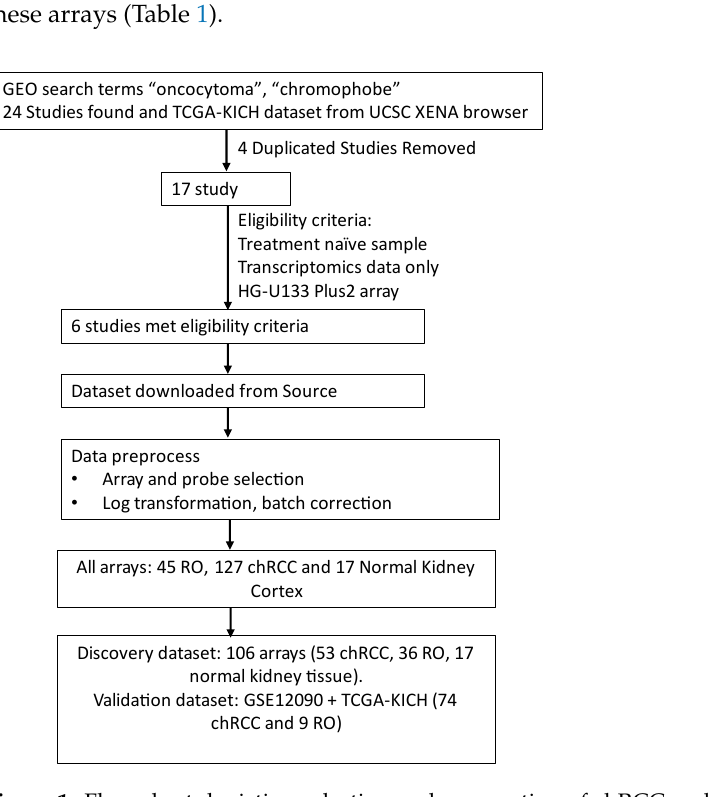
Figure 1. Flow chart depicting selection and preparation of chRCC and RO arrays from GEO for meta-analysis. Table 1. GEO datasets selected for chromophobe renal cell carcinoma (chRCC) and renal oncocy- toma (RO) classification as discovery and validation datasets. Table contains details on number of probes, total number of arrays in the study and number of arrays selected under chRCC, RO and normal kidney tissue.